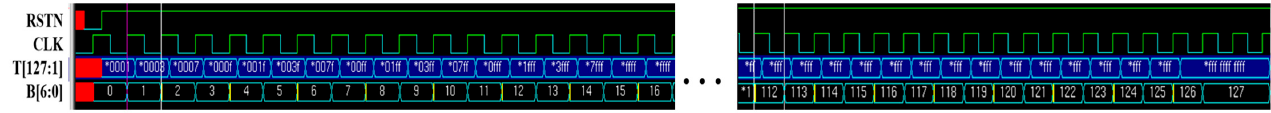
Figure 14. Encoder block post-layout simulation.